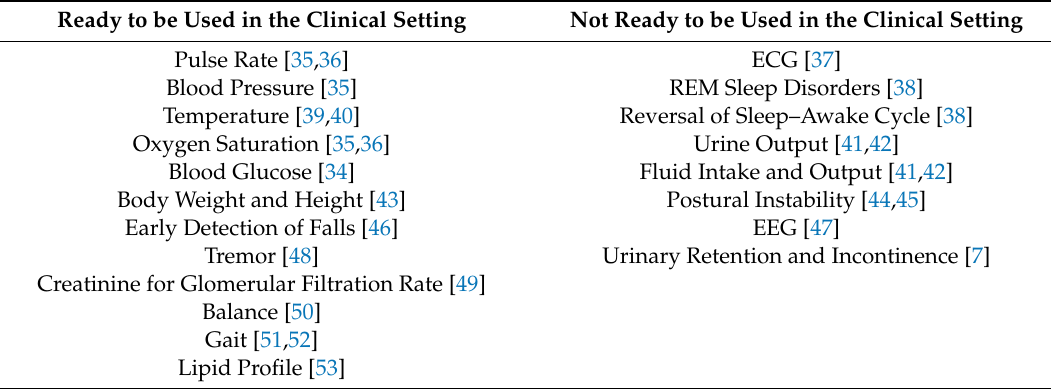
Table 1. List of data types that can be collected by the available Internet of things (IoT) devices. Ready to be Used in the Clinical Setting